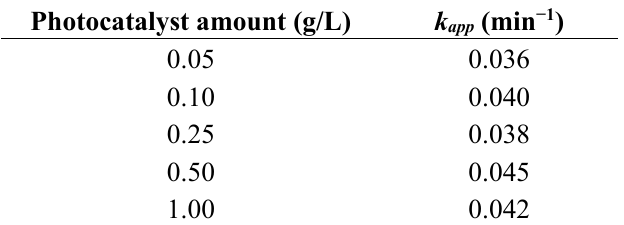
Table 2. Apparent kinetic parameters for paracetamol